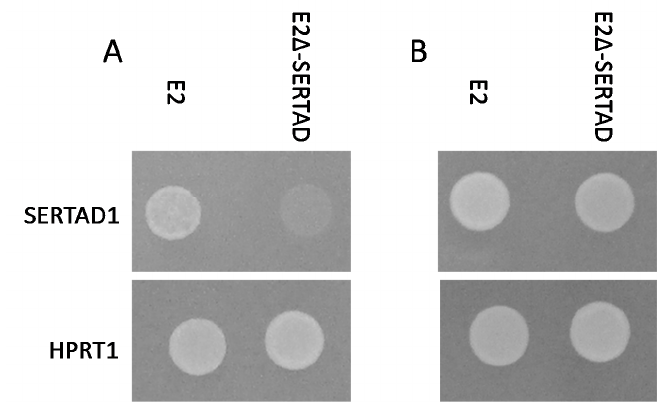
Figure 2. The yeast two-hybrid protein-protein interaction of CSFV protein E2 or E2- ∆ SERTAD (T149A, Y325h and H335R) coupled to the Gal4 binding domain with SERTAD1 or HPRT coupled to the Gal4 activation domain. Spots of strains (10 uL), expressing the indicated constructs were spotted on ( A ) selective media SD-Ade/His/Leu/Trp or ( B ) non-selective media SD-Leu/Trp.